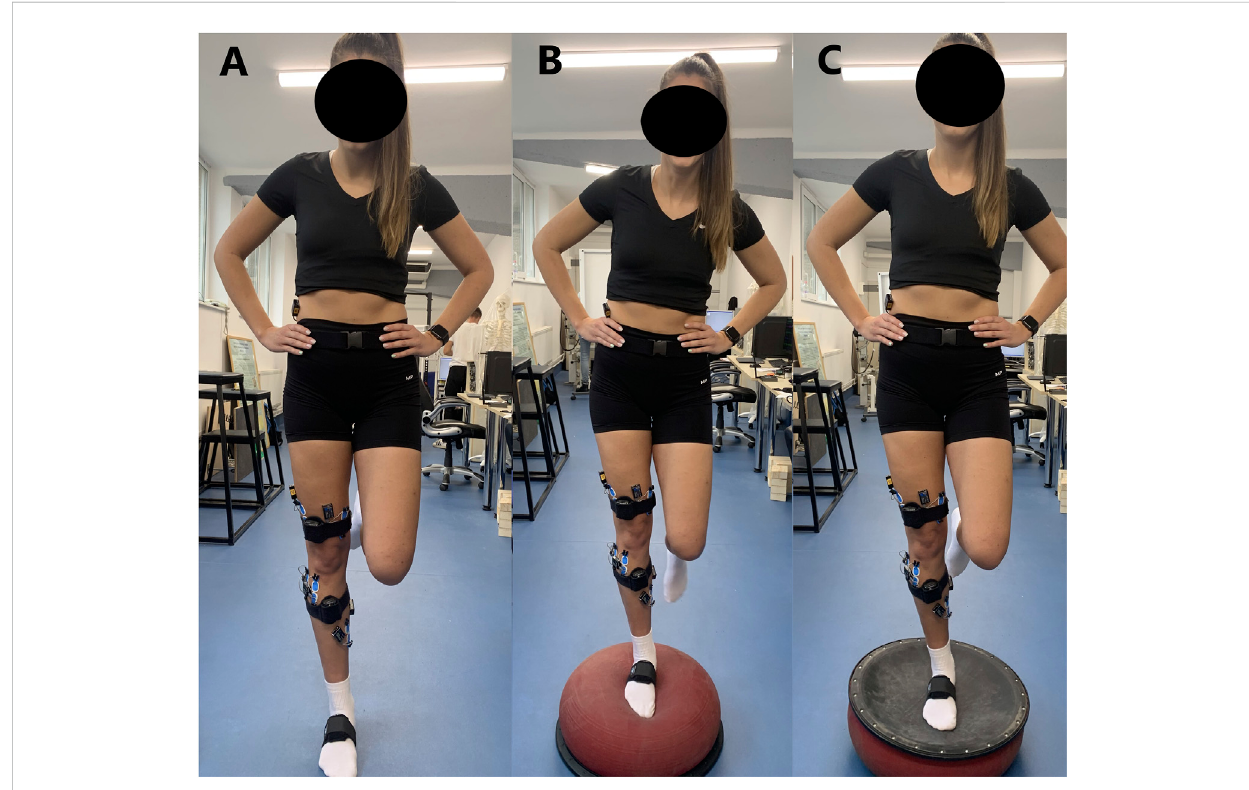
Shows a subject performing single legged balance teston different surfaces. (A) Floor, (B) Bladder side of the Togu Jumper, (C) Flat sideof the Togu